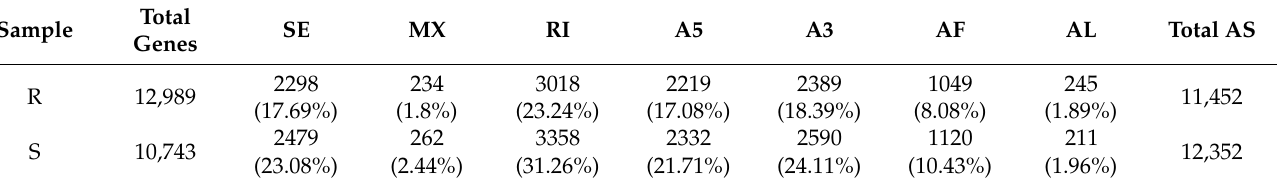
Table 3. Summary of alternative splicing events.